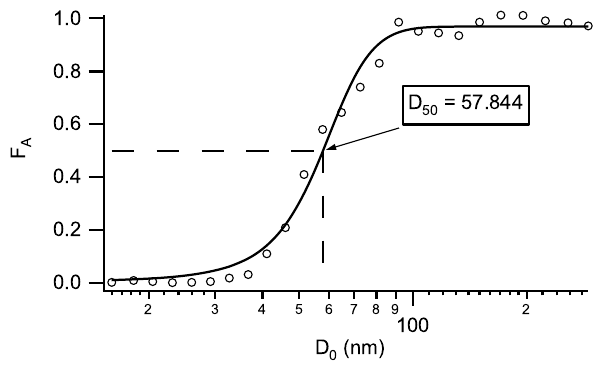
Fig. 8. Example plot of F A vs. D 0 , with a sigmoid fit used to deter- mine D 50 measured during the MAP campaign at 0.37% supersat- uration.